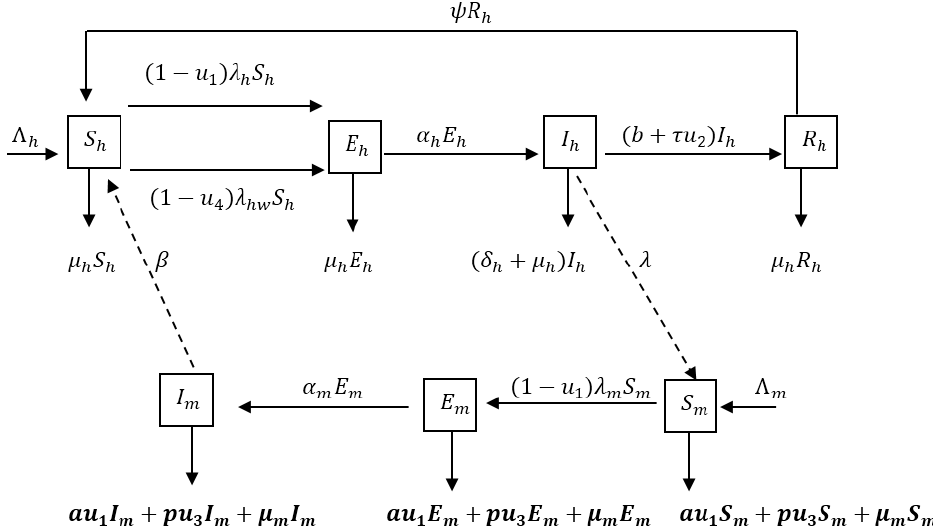
Figure 1. Malaria model with interventions.